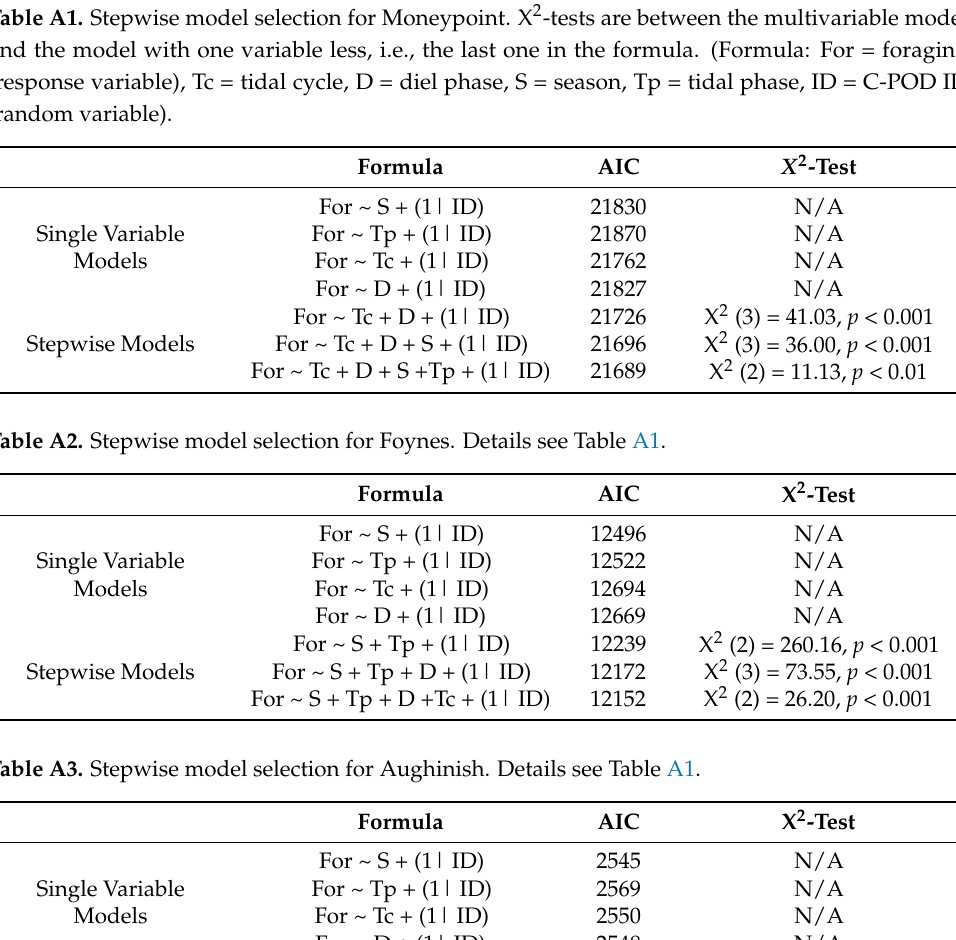
Table A1. Stepwise model selection for Moneypoint. X 2 -tests are between the multivariable model